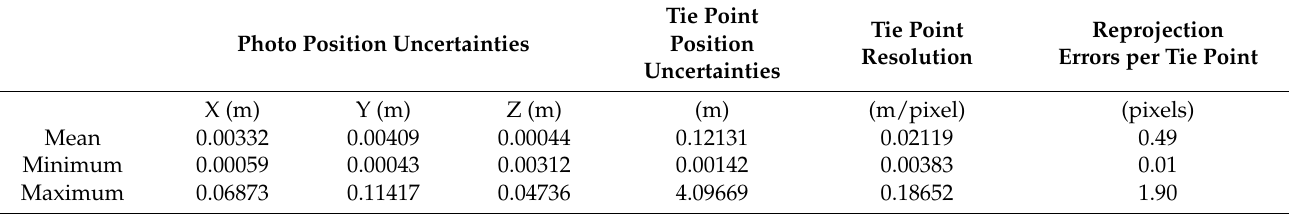
Table 2. Quality report of aero triangulation.